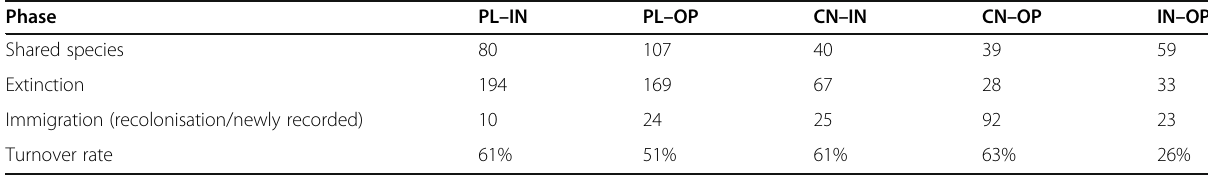
Table 1 Bird species richness changes: shared species, local extinction, immigration and turnover rate, throughout the dam development phases in Puah Lake Catchment, Hulu Terengganu, Peninsular Malaysia. Abbreviations: PL pre-log, CN construction, IN inundation, OP